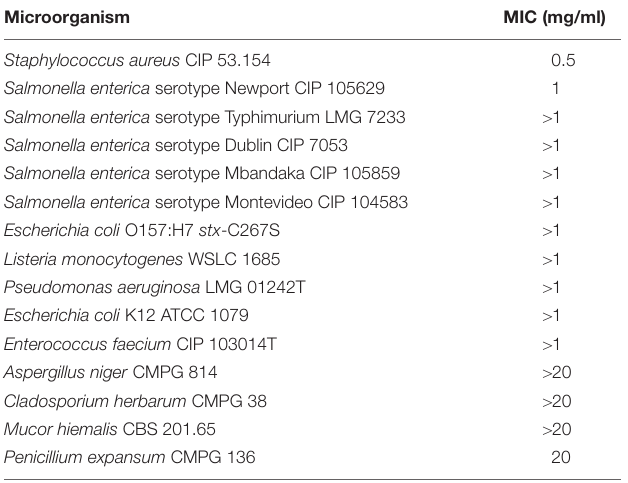
TABLE 1 | Antimicrobial activity of